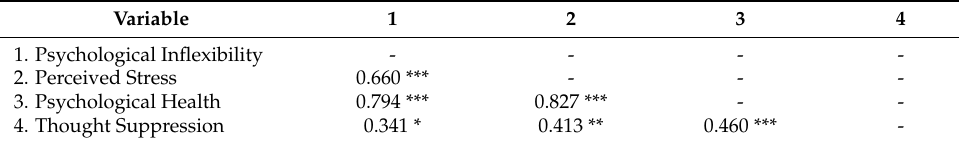
Table 4. Correlations matrix: 6-PAQ, PSS, GHQ and WBSI for group 2 (high PI, n = 52). Variable